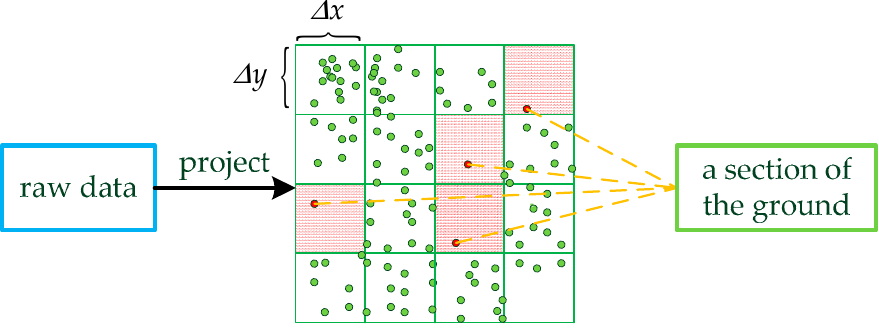
Figure 4. The grid threshold method. The original data are projected two-dimensionally and meshed. Part of the ground data consists of these points whose quantity is one in the grid.